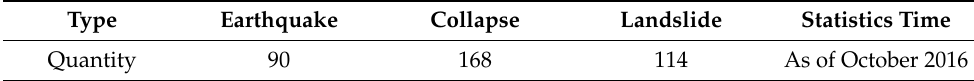
Table 1. Statistics of geological disasters in the Pinggu